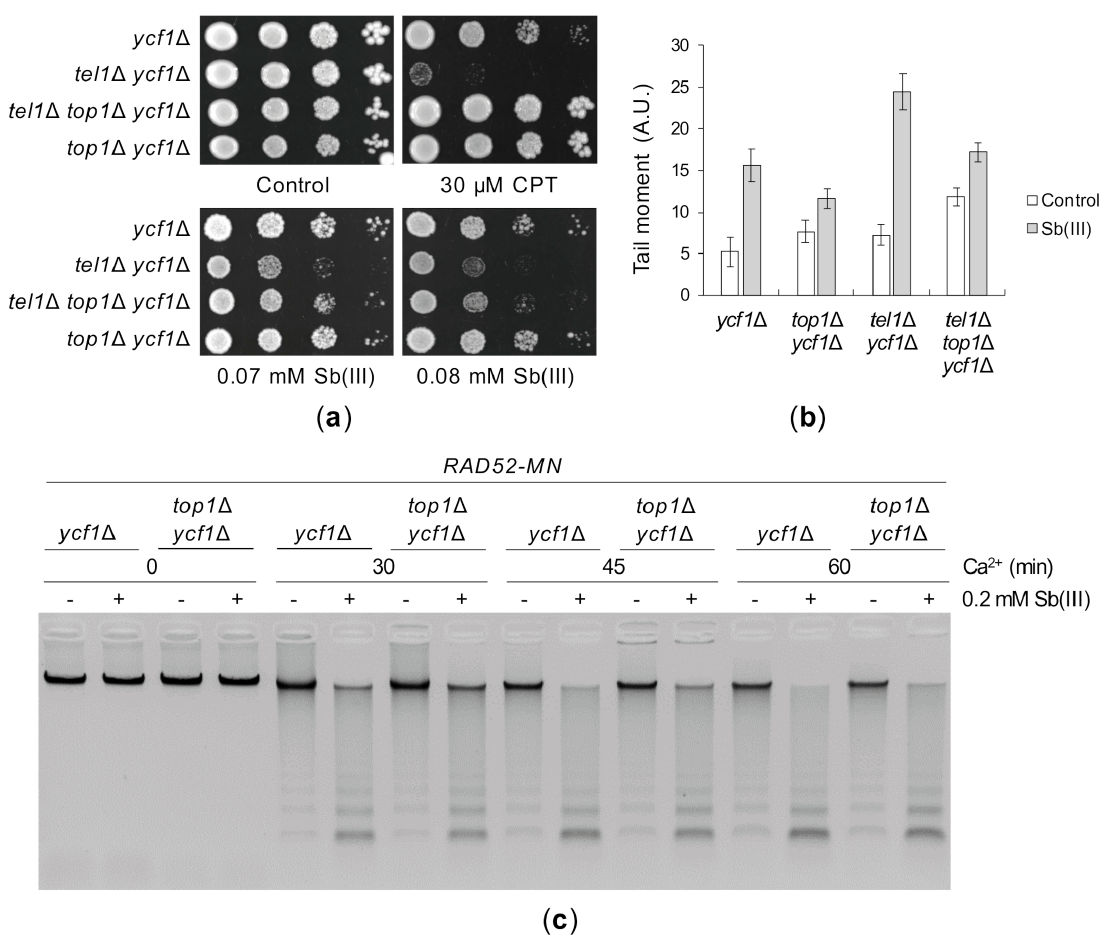
Figure 9. Sb(III) triggers Top1-dependent DNA lesions. ( a ) The lack of Top1 slightly improves the growth of cells with the tel1 ∆ mutation in the presence of Sb(III). Exponentially growing cell cultures were serially diluted and spotted onto YPD plates with or without indicated compounds and incubated at 30 ◦ C for two days. ( b ) Sb(III)-induced DNA breaks partially depends on the activity of Top1. Exponentially growing cells were treated with 0.2 mM Sb(III) for 2 h or mock-treated and analyzed by the comet assay as described in Figure 3C. A.U., arbitrary units. ( c ) Deletion of TOP1 decreases levels of Sb(III)-induced replicative DNA lesions. The presence of ssDNA-containing DNA lesions were assessed by ChEC as described in Figure